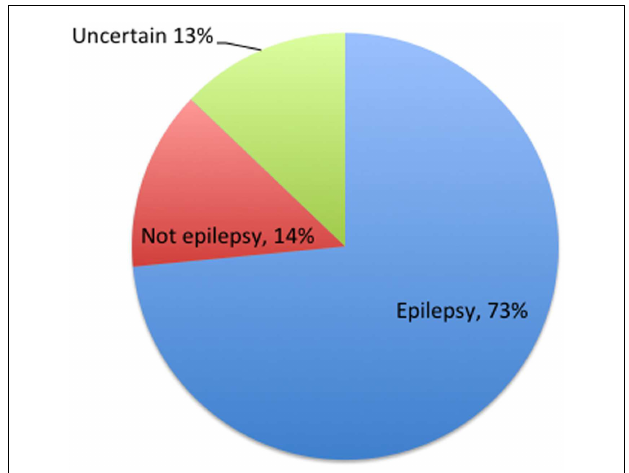
FIGURE 1 | Percentages of uncertain diagnoses as defined by mobile app in 132 patients